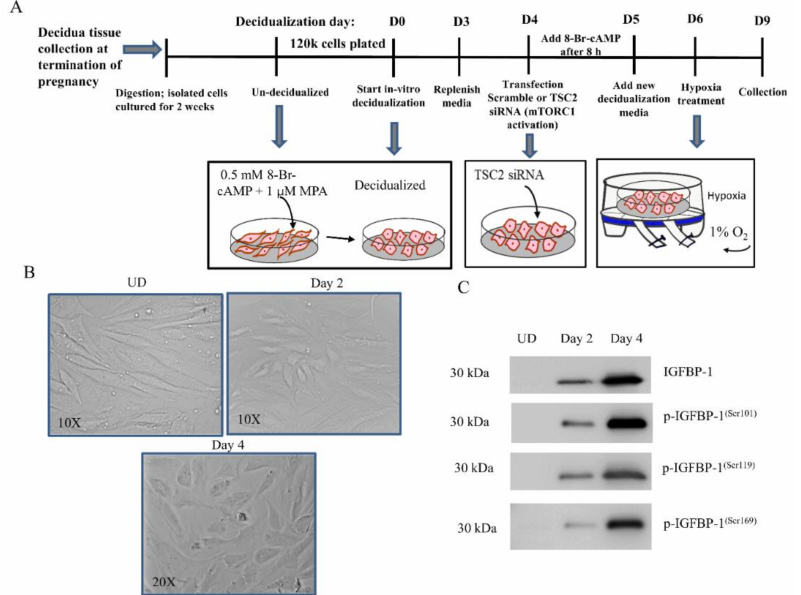
Figure 1. Evaluation of decidualization of HESCs isolated from first-trimester placenta. Primary HESC decidualization and experimental strategy ( A ). Morphological change of primary HESCs after 4 days of decidualization via supplementation with combined 8-Br-cAMP + MPA ( B ). Un- decidualized (UD) primary HESCs maintained an elongated spindle shape throughout the culture period (B-UD, 10 × ). Cells treated with 8-Br-cAMP + MPA acquired an ovoid-shaped morphology indicative of decidualization at (B-Day 2, 10 × ) and (B-Day 4, 20 × ). Total IGFBP-1 secretion and phosphorylation at Ser101, Ser119, and Ser169 were detectable at 48 h treatment of cells with 8-Br- cAMP + MPA and reached a maximum peak by 4 days ( C ). Western blot analysis using equal aliquots of cell media (36 µ L) of HESCs (UD) control ( n = 3) and 8-Br-cAMP + MPA-treated cells (C, Day 2, Day 4) ( n = 3) for 4 days showed decidualization of primary HESCs concomitantly increased